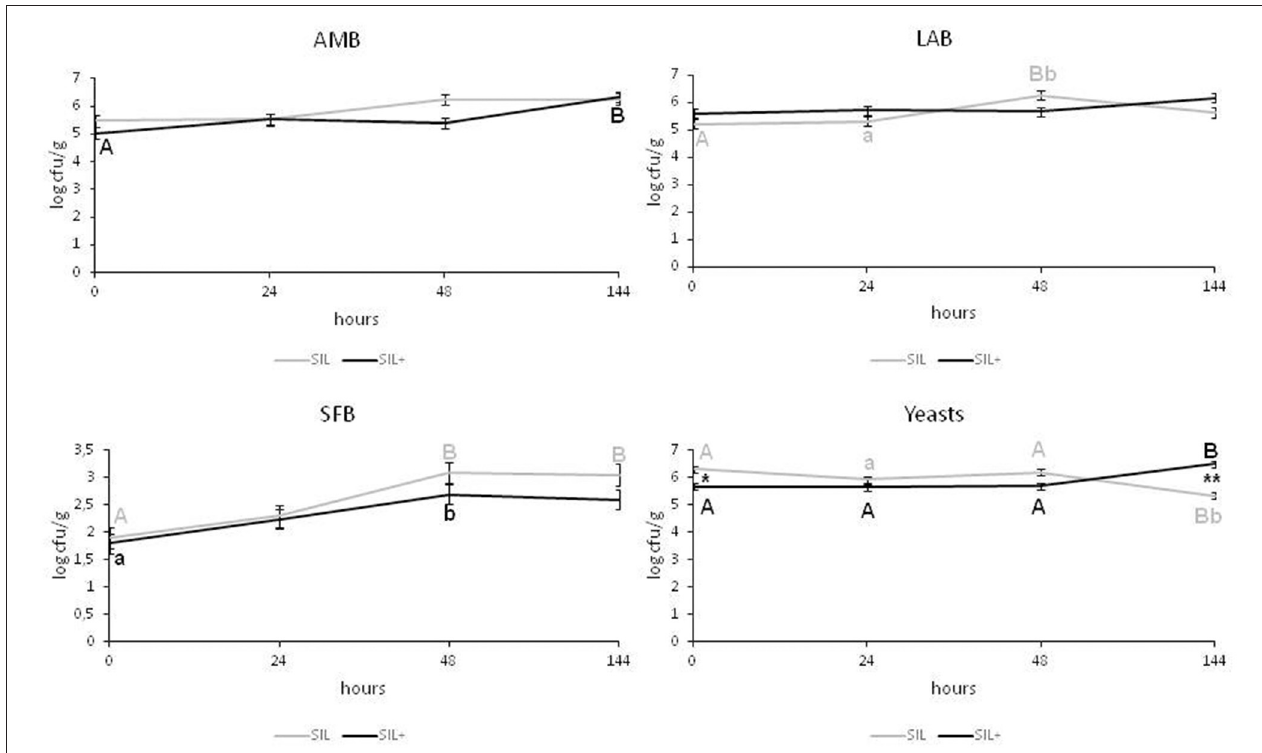
FIGURE 2 | Microbiological characteristics of the silage with (SIL + ) or without (SIL) L. plantarum 5BG inoculation. The microbial loads (log cfu/g) of total aerobic mesophilic bacteria (AMB), lactic acid bacteria (LAB), and spore-forming bacteria (SFB) and yeasts are reported. Values of each time point are the means of three replicates ± standard error (error bars). Different letters of the same color show statistical differences among time (A, B = P < 0.01; a, b = P < 0.05); *, ** show statistical differences between groups at the same time (* P < 0.05; ** P <